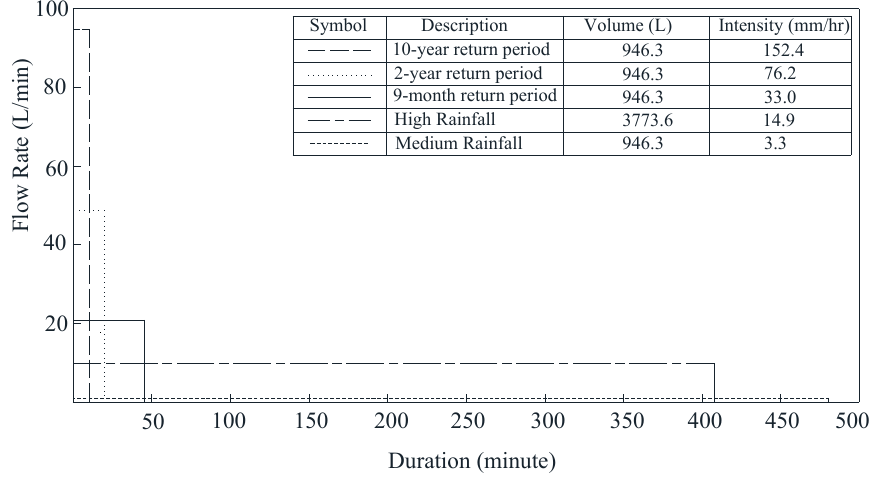
Figure 5. Simulated rainfall scenarios.